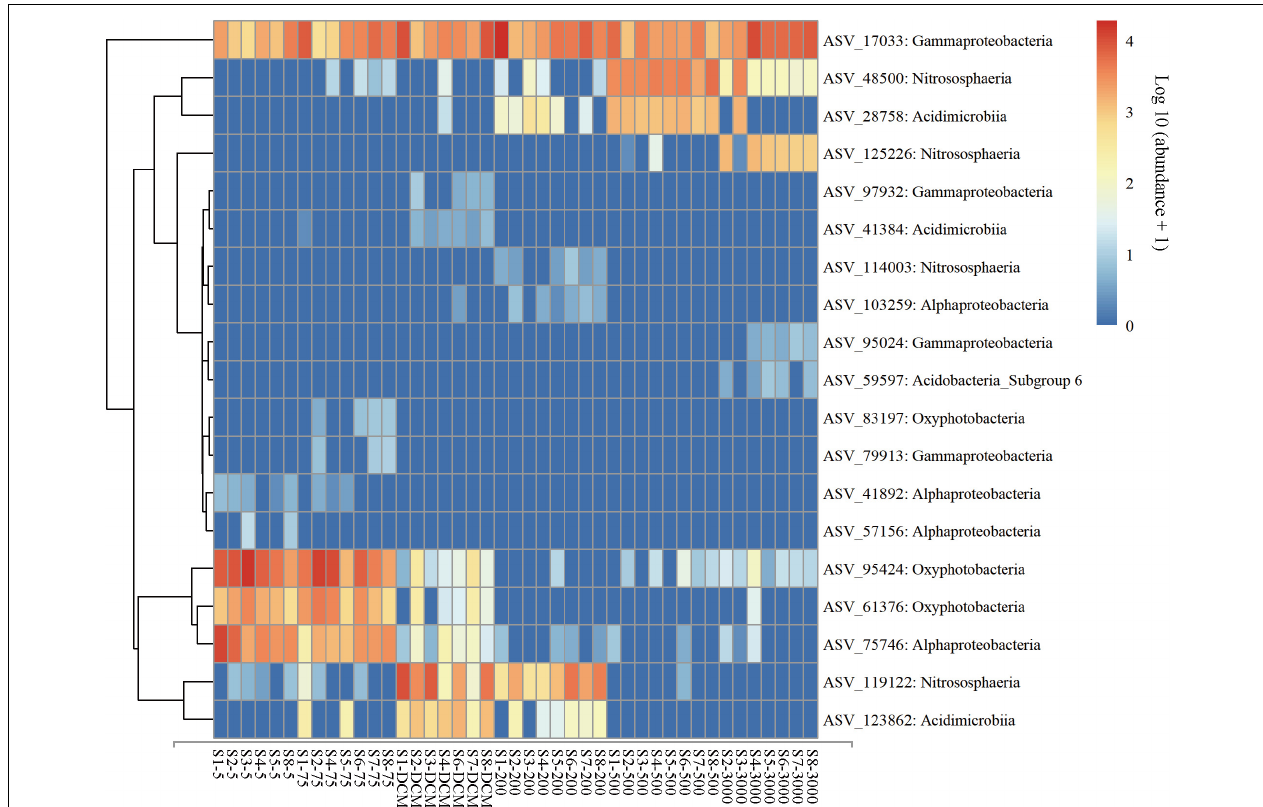
FIGURE 4 | Abundance of the key ASVs identified from similarity percentage analysis for the all, abundant, and rare microbial taxa among six depth groups (5 m, 75 m, DCM, 200 m, 500 m, and 3,000 m). Microbial abundance was scales with log transformation in the heatmap.